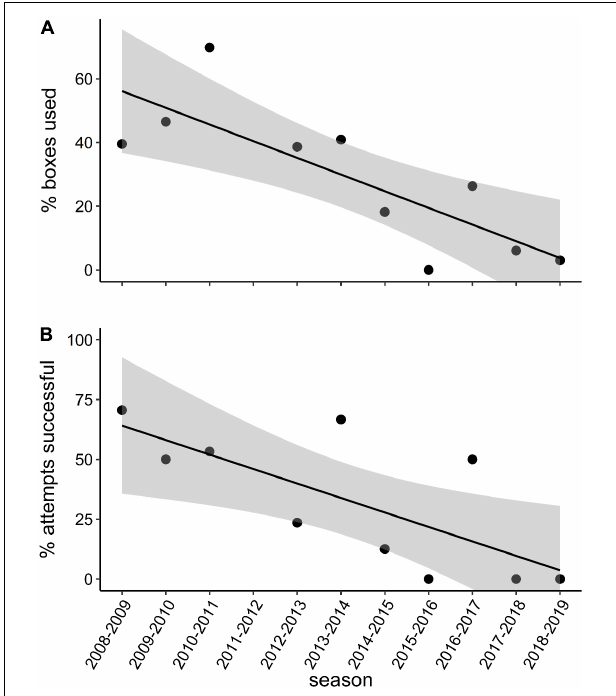
Table 2 ). The interaction between the percentage DaysT